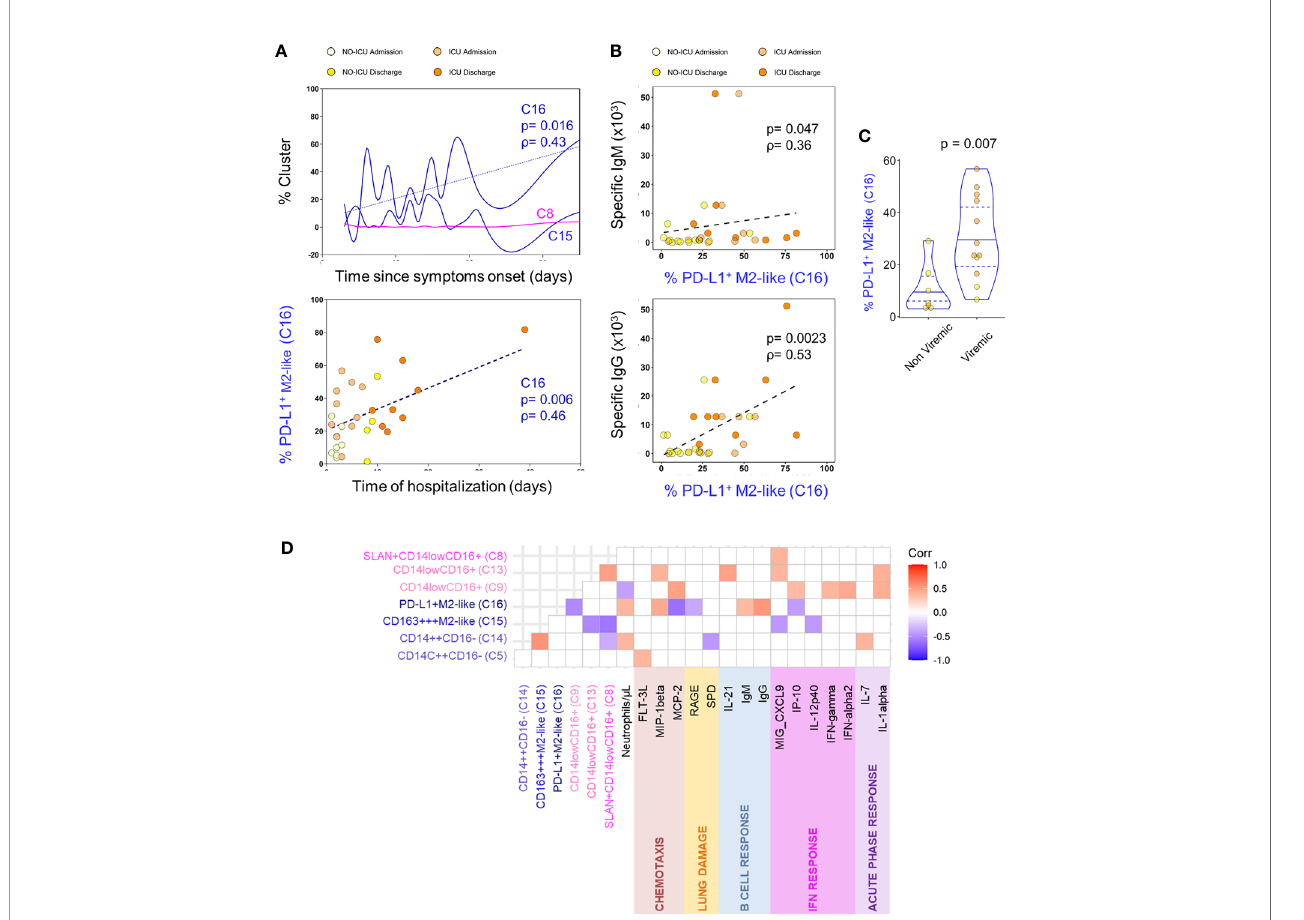
FIGURE 4 | M2-like monocytes expanded until discharge and correlated with the decrease of in fl ammatory analytes. (A) Correlation of indicated cluster frequencies with days since symptoms onset (top) and time of hospitalization (bottom). (B) Correlation between PD-L1+M2-like cluster frequency and anti-SARS-CoV-2 speci fi c IgM (top) and IgG (bottom) titers. (C) Frequency of PD-L1+M2-like cluster at admission in viremic versus non-viremic patients; comparison done using Mann-Whitney U-test and P value are shown. (D) Correlation matrix identifying the relation between monocyte X-shift clusters and serum markers with only signi fi cant correlations showed (p-value <0.05); Spearman Rank correlation coef fi cient were